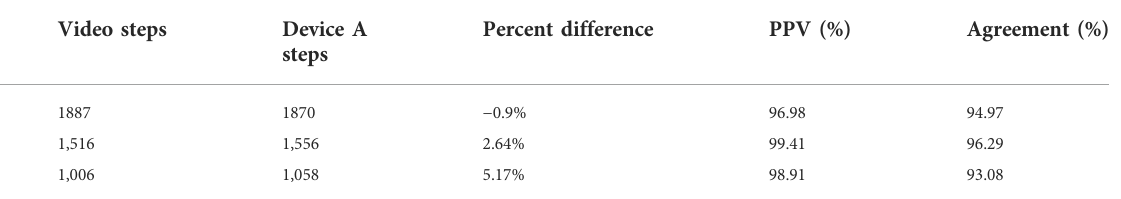
™ in detecting steps.